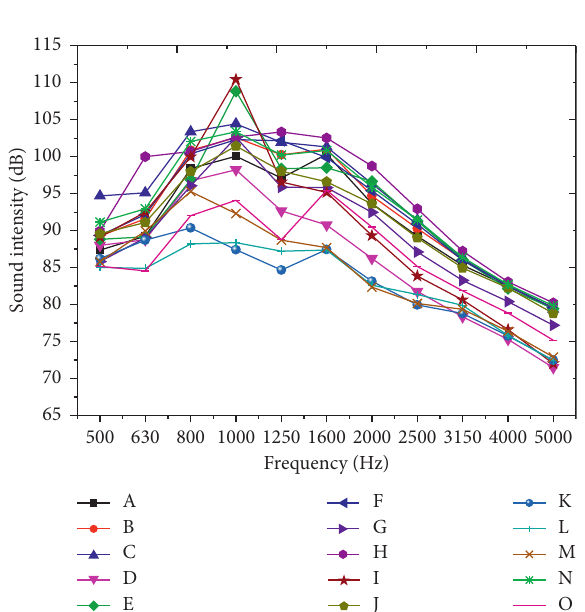
Figure 7: Comparison of the 1/3 octave of different pavement